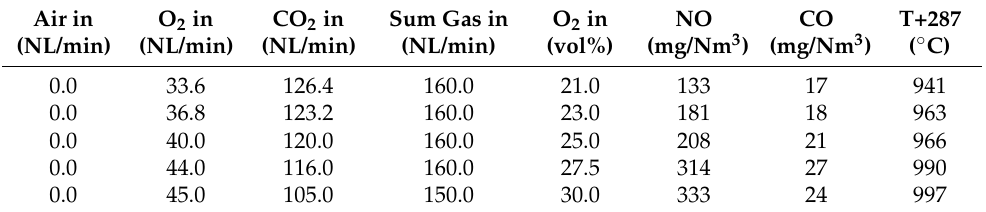
Table 2. Varying O 2 /CO 2 concentrations, fixed total flow rate. Feedstock effect: 1.3 kg/h; reactor temperature set at 1000 ◦ C.